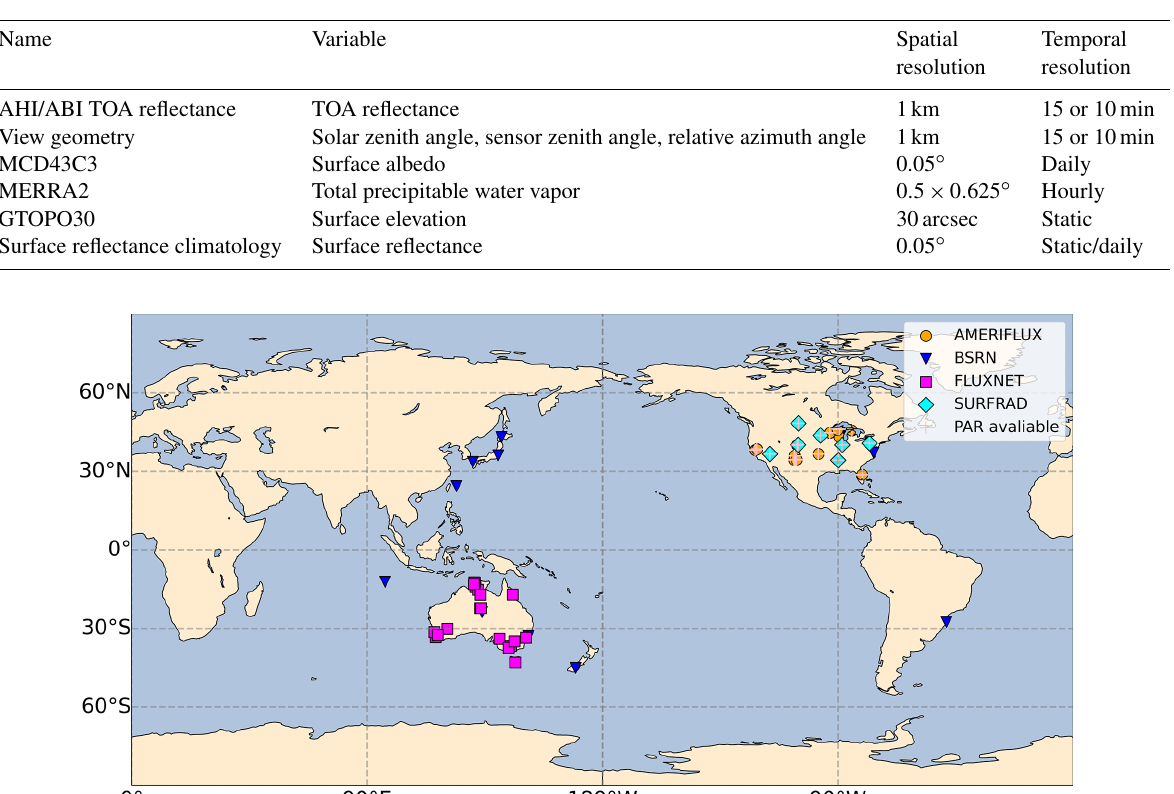
Figure 2. The map of ground stations and their networks used for validating the GeoNEX DSR–PAR product.